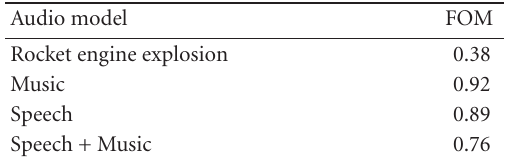
Table 2: FOM results: audio retrieval, di ff erent intermediate con- cepts.